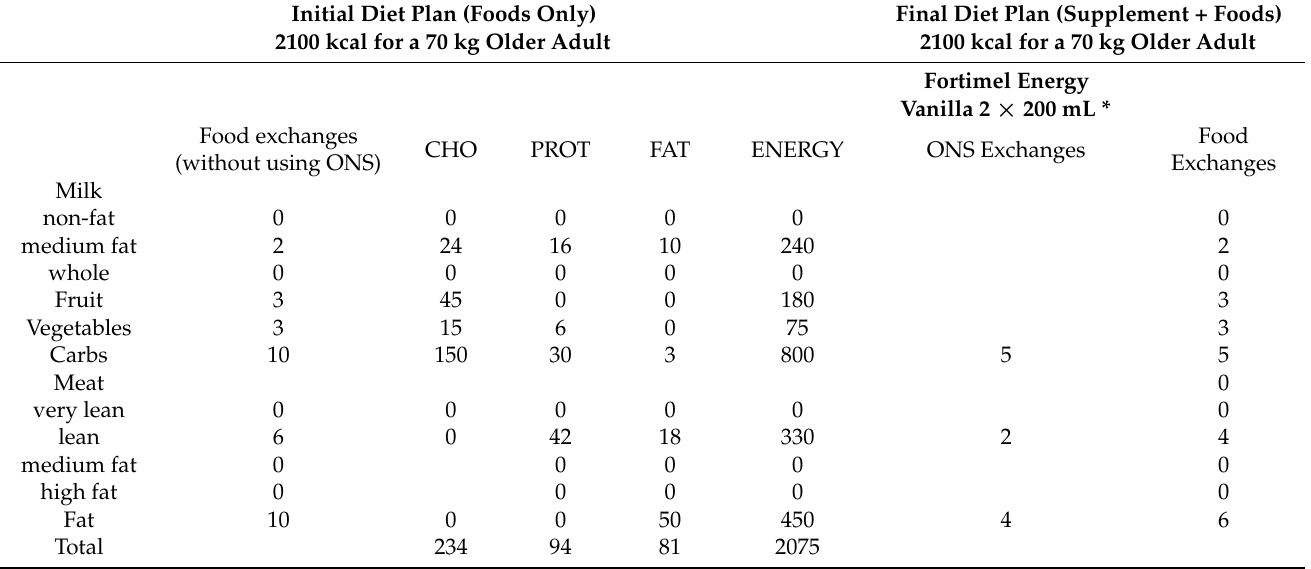
Table 3. Example of a 2100 kcal diet plan with incorporation of